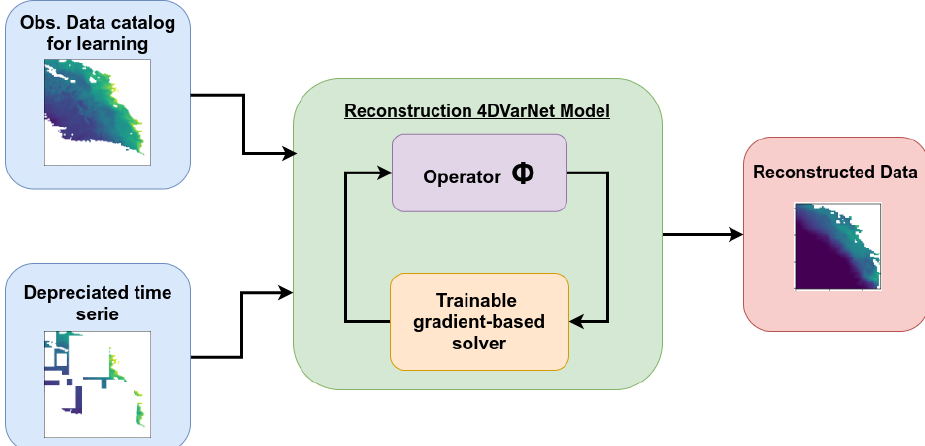
Figure 2. Workflow of the proposed framework for the reconstruction NAP field with the 4DVarNet. A given observation dataset catalogue is provide for the learning phase of the model. The interpolator Φ is trained and optimised by the solver. Then the model is able to reconstruct the irregularly sampled time series input into the reconstructed